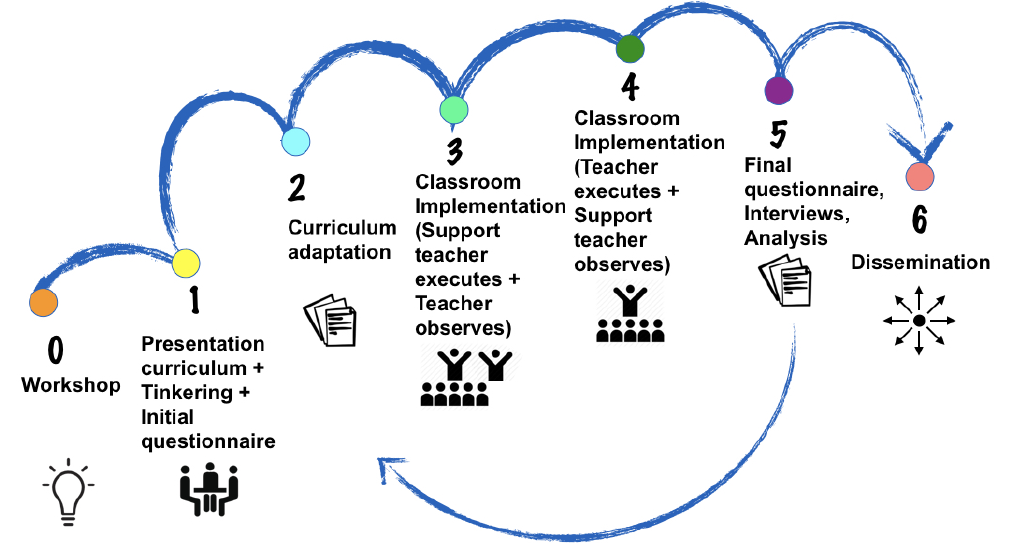
Figure 2. Methodology of the teachers’